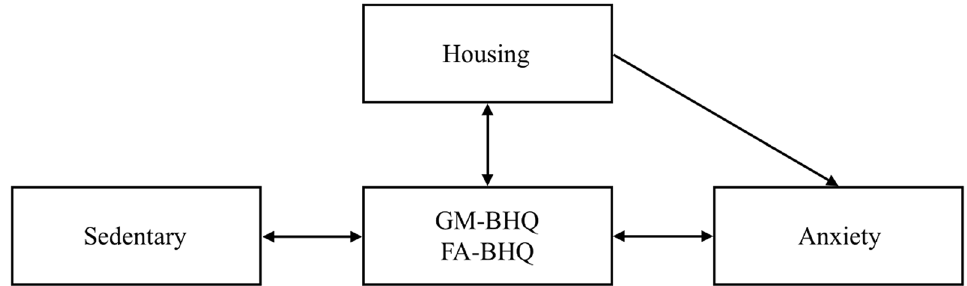
Figure 1. Hypothesized associations among housing quality, weekend/holiday sedentary behavior, brain health, and anxiety. The relationships shown below are assumptions based on the current literature, and are not in any way definitive or